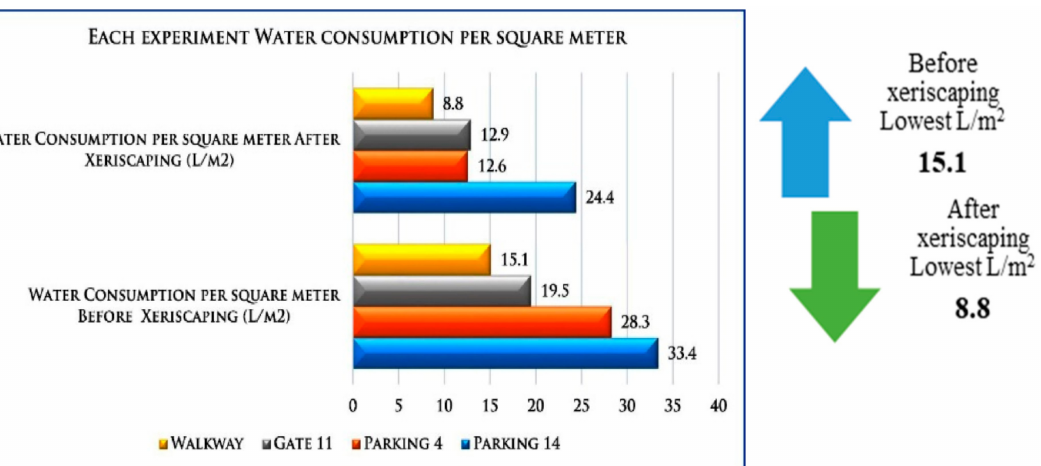
Figure 21. Water consumption comparison before and after applying xeriscaping for each study field experiment.